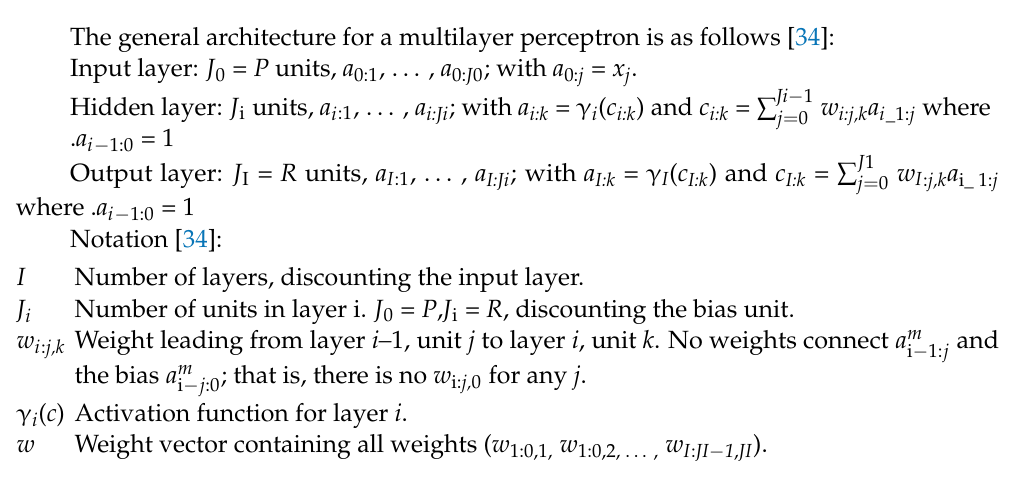
Figure 3. Sensitivity analysis. Using a sensitivity analysis, the independent variables were ranked according to their importance for predicting the dependent variable and in determining the neural network.